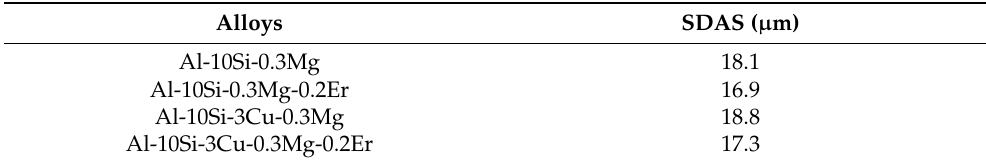
Table 2. Effect of alloying elements on secondary dendrite arm spacing (SDAS) in Al-Si alloys with different composition.